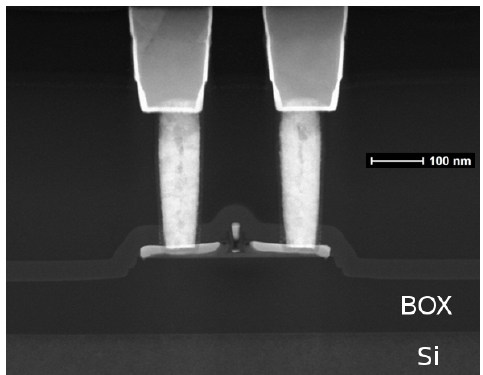
Figure 7. Transmission electron micrograph of single-gate device after back-end process. The device is at the center, and only the Source and Drain vertical vias and copper lines are visible. Tungsten contact and standard Cu back-end-of-the-line process are used, as usual for advanced CMOS